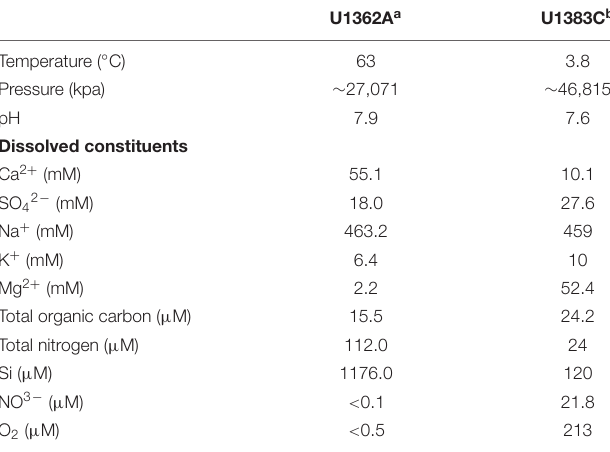
TABLE 1 | Chemical compositions of basaltic crustal fluids collected from CORK observatories at boreholes U1362A and